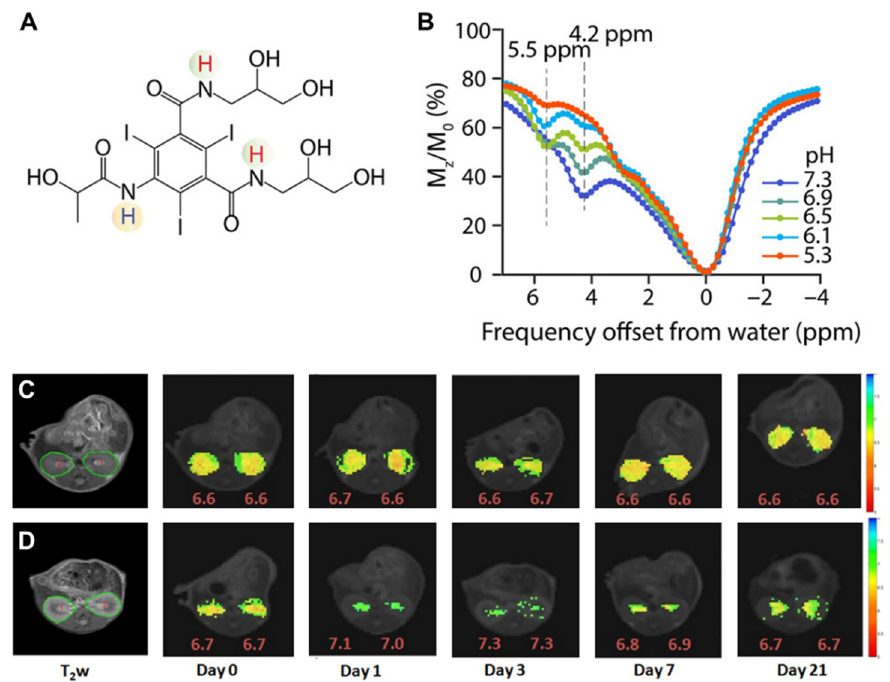
Figure 5. Iopamidol as pH imaging agent tested in mice. ( A ) Structure of iopamidol with exchangeable protons highlighted, which produce CEST contrast at 4.2 and 5.5 ppm; ( B ) CEST Z-spectra of iopamidol in blood serum for pH = 5.3, 6.1, 6.5, 6.9, and 7.3. Panels ( C , D ) adopted from Pavuluri et al. in [70]; Representative anatomical (T 2w ) and superimposed color-coded pH maps obtained 15 min after Iopamidol injection at indicated time points in control group ( C ) and in AKI group ( D ). Panels ( C , D ) adopted from Longo et al. in [69].